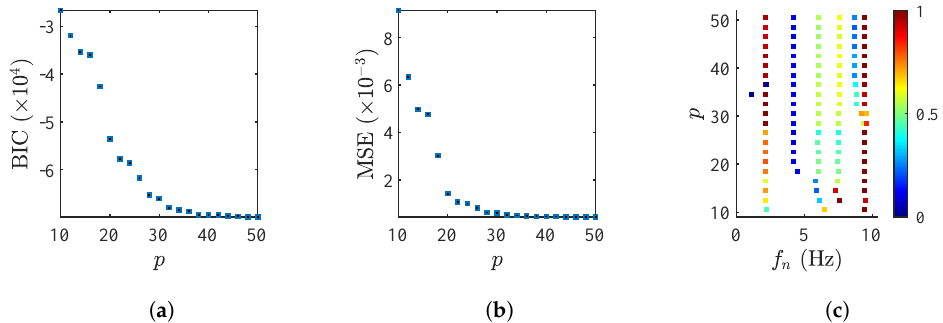
Figure 8. Spring-mass-damper: performance of the ARX model order selection criteria: ( a ) BIC. ( b ) MSE. ( c ) Dispersion-corrected frequency stabilization diagram.